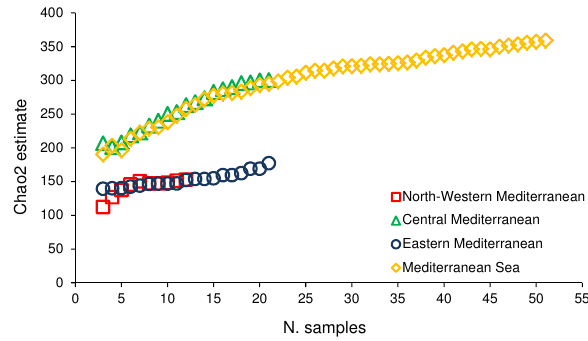
Fig. 7. Plot of randomised, cumulative Chao2 species richness against number of samples of the north-western, central and east- ern Mediterranean Sea and of samples of the whole Mediterranean